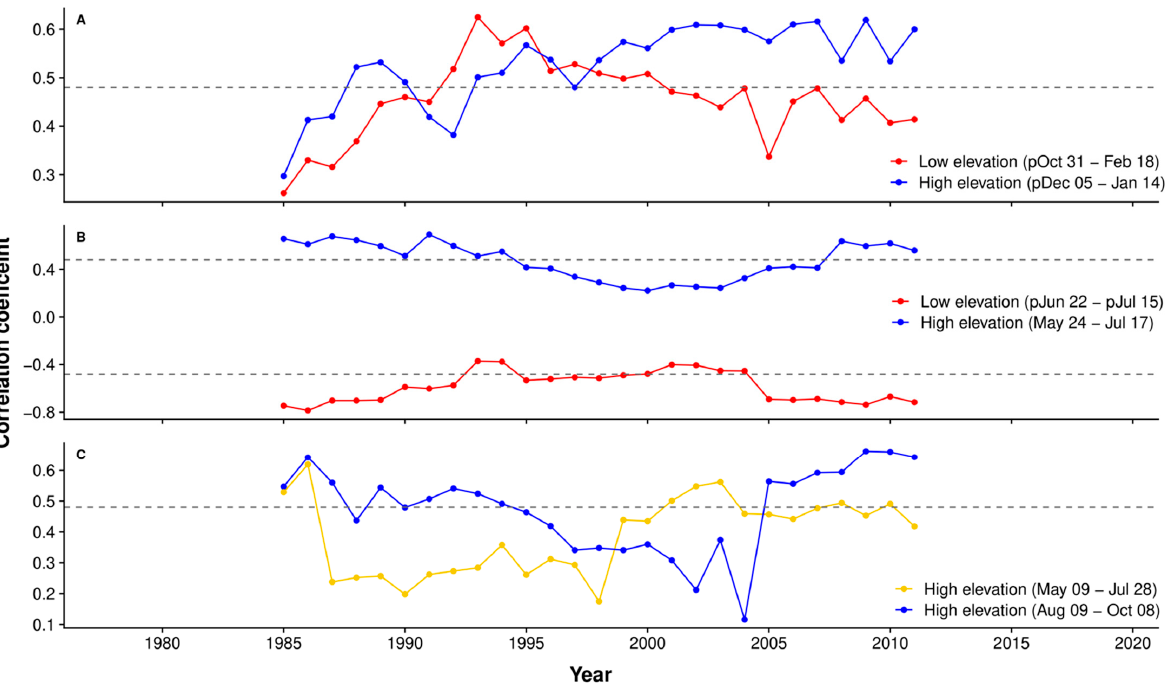
Figure 5. The 15-year running correlations between air temperature and tree-ring proxies (( A )—tree-ring width; ( B )—basal area increment; ( C )—blue intensity). The legend contains the site location and period (with the dashed line representing a significant correlation coefficient for p < 0.05, n = 15).